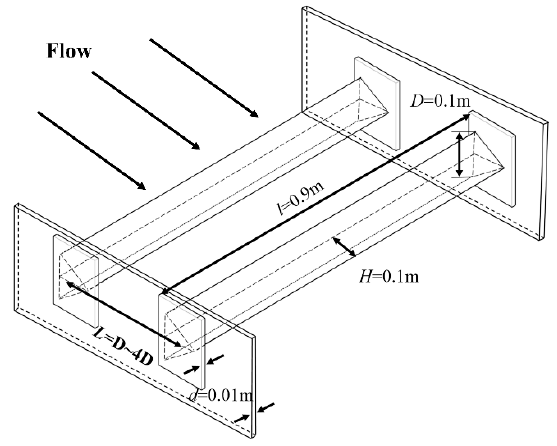
Figure 6. Physical model.